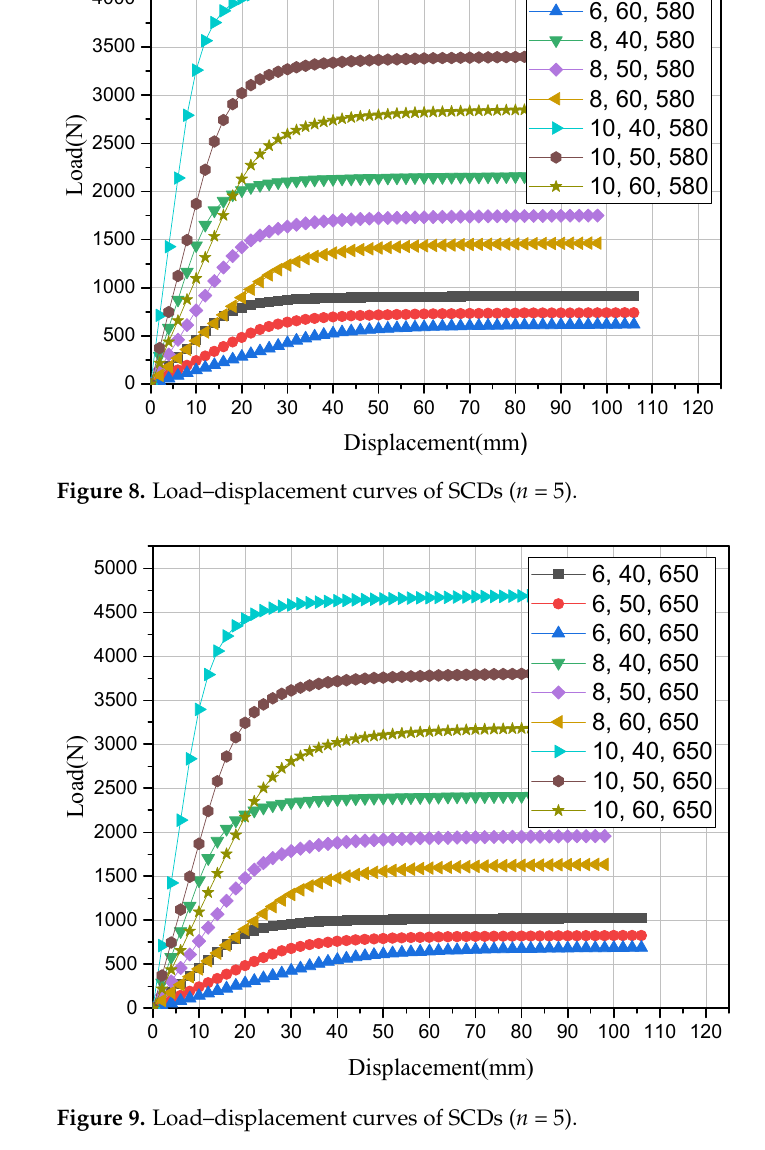
Figure 9. Load–displacement curves of SCDs ( n =